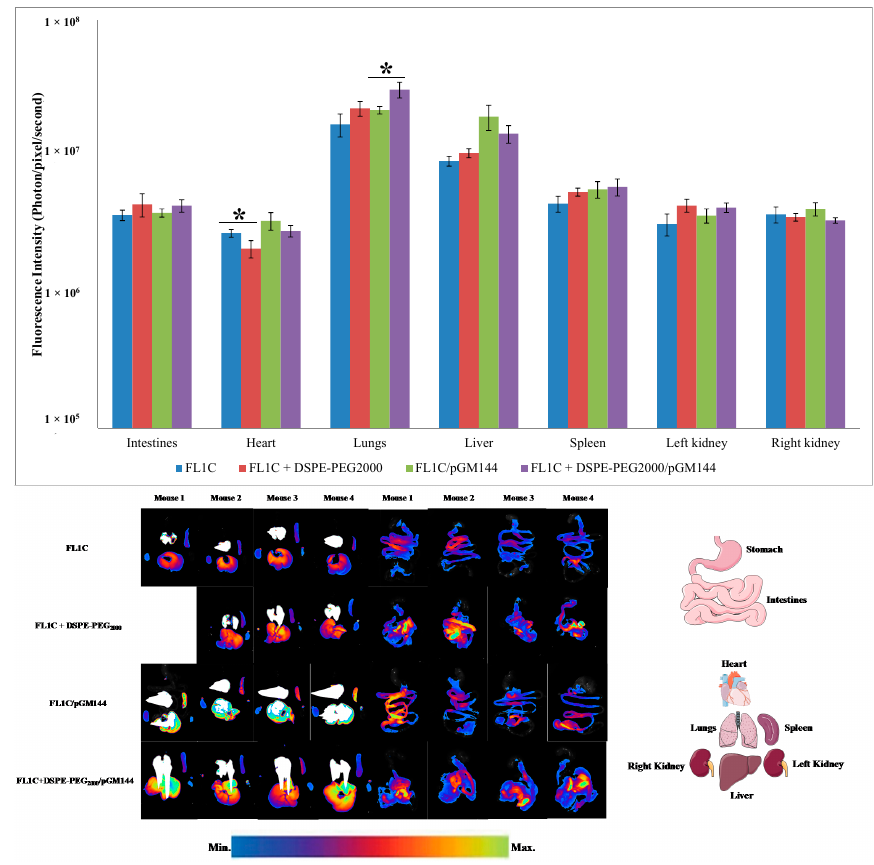
Figure 7. Biofluorescence of FL1C-based liposomes and lipoplexes from isolated organs after the systemic administration. Twenty-four hours post injection, mice were sacrificed by cervical dislocation and organs were collected for analysis. Fluorescence intensity was measured in different organs (lungs, liver, spleen, heart, intestines and kidneys). Results were expressed in photon/pixel/second obtained with each formulation reflecting the fluorescence intensity on different organs as mean ± SD ( n = 4). * p < 0.005.